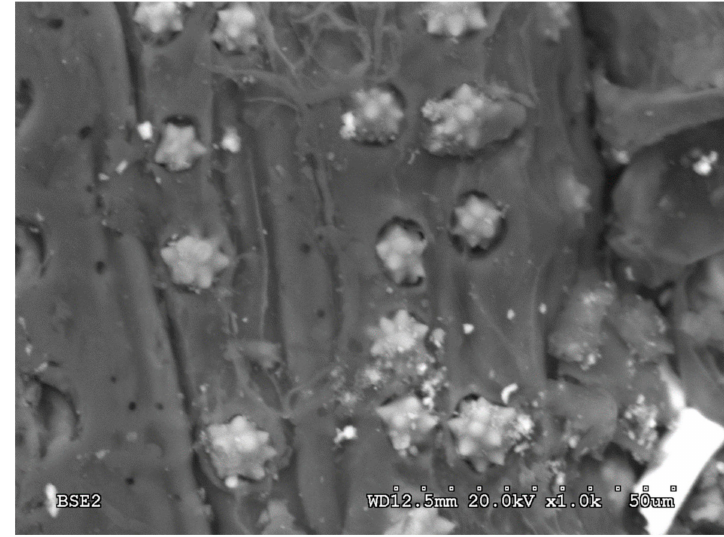
Figure 3. Micrography of the longitudinal section of Canary Islands palm trunk.